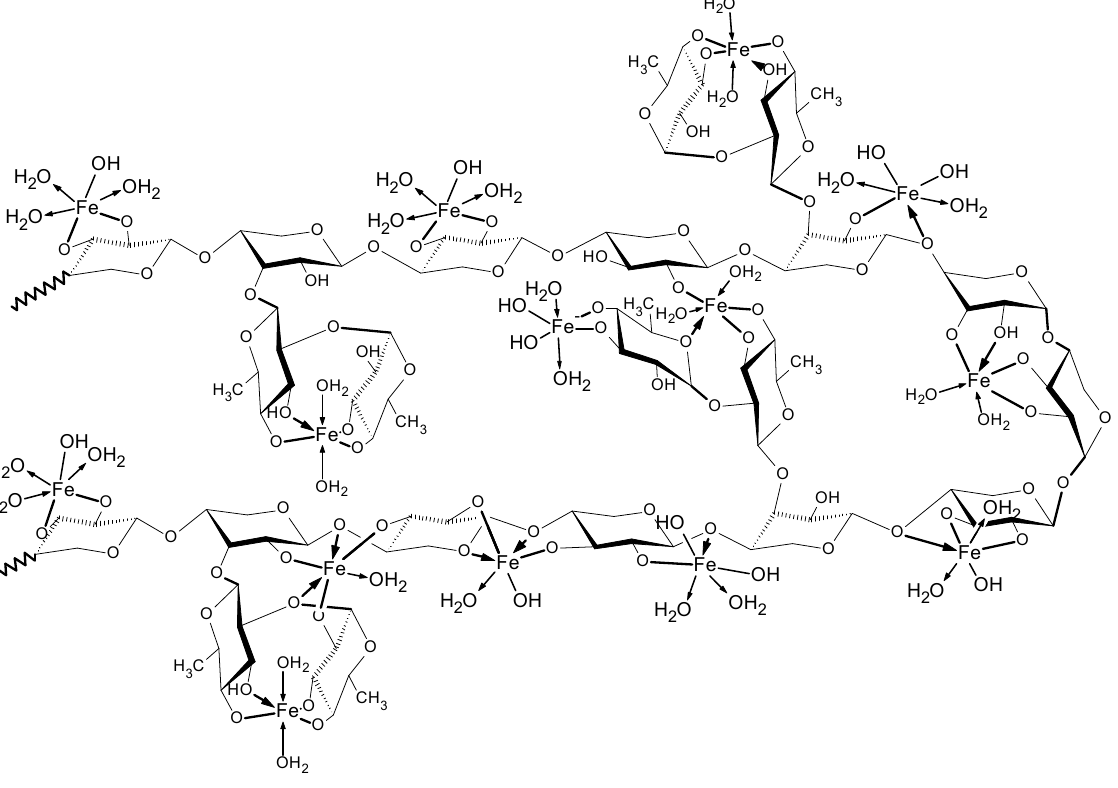
Figure 6. Proposed structure of the Fe(III)–rhamnoxylan complex.